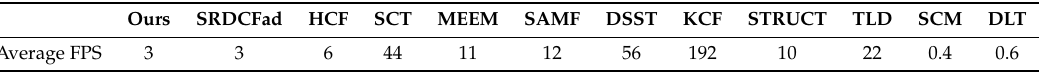
Table 1. Speed of the